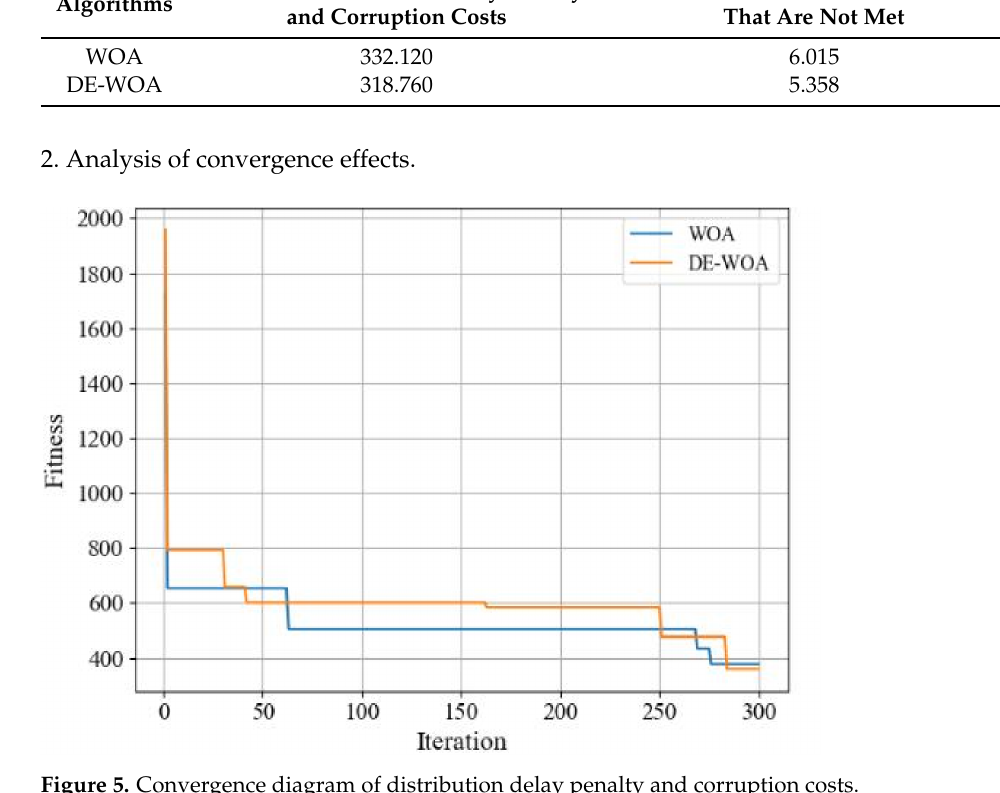
Figure 5. Convergence diagram of distribution delay penalty and corruption